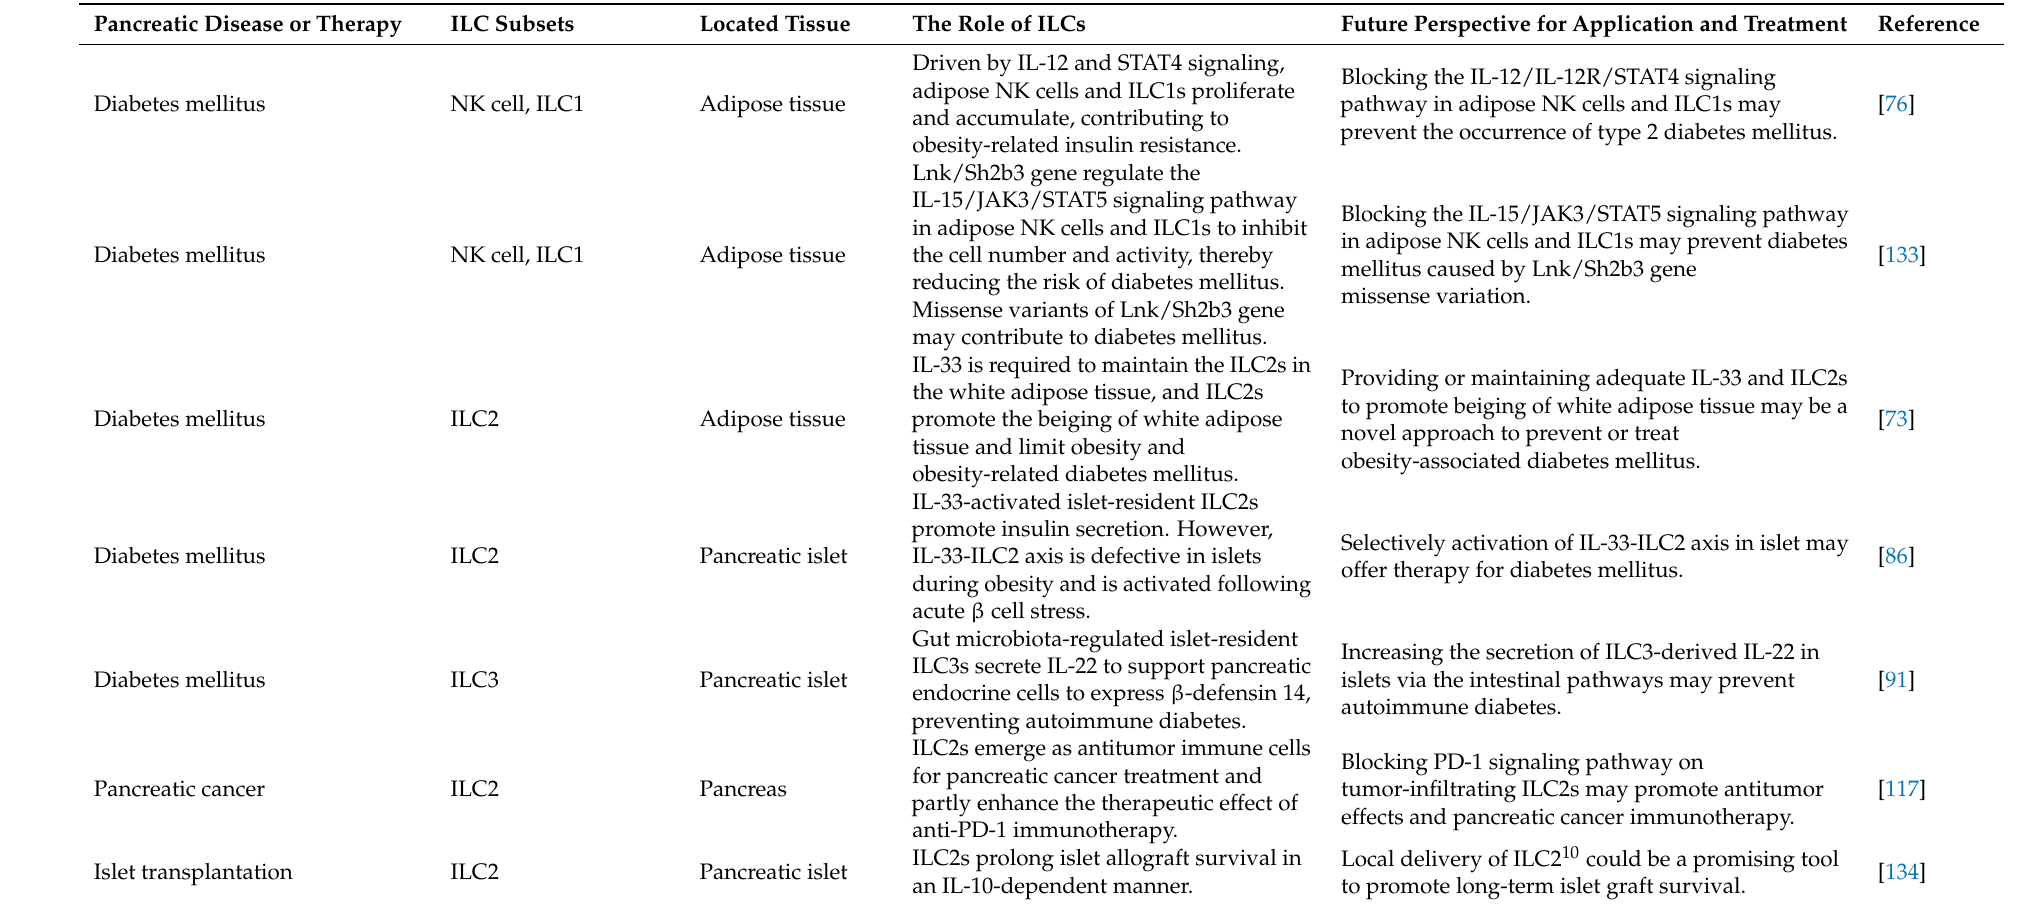
Table 1. Animal studies identifying ILC subsets associated with pancreatic disease and